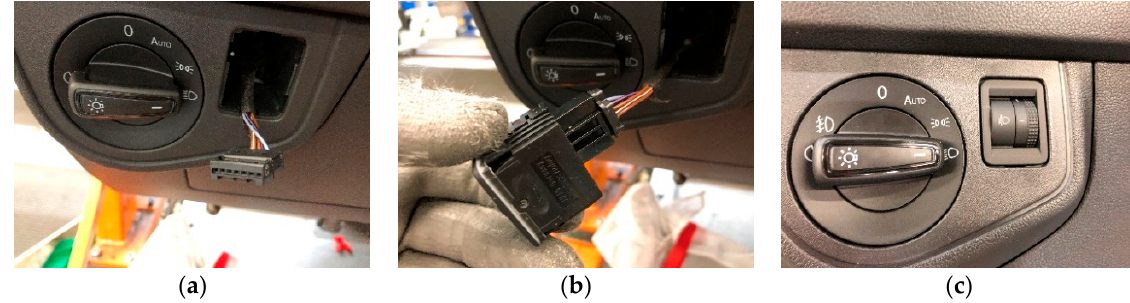
Figure 5. Dimmer installation: ( a ) connection wiring, ( b ) dimmer connection, ( c ) insertion of the dimmer in the dashboard.